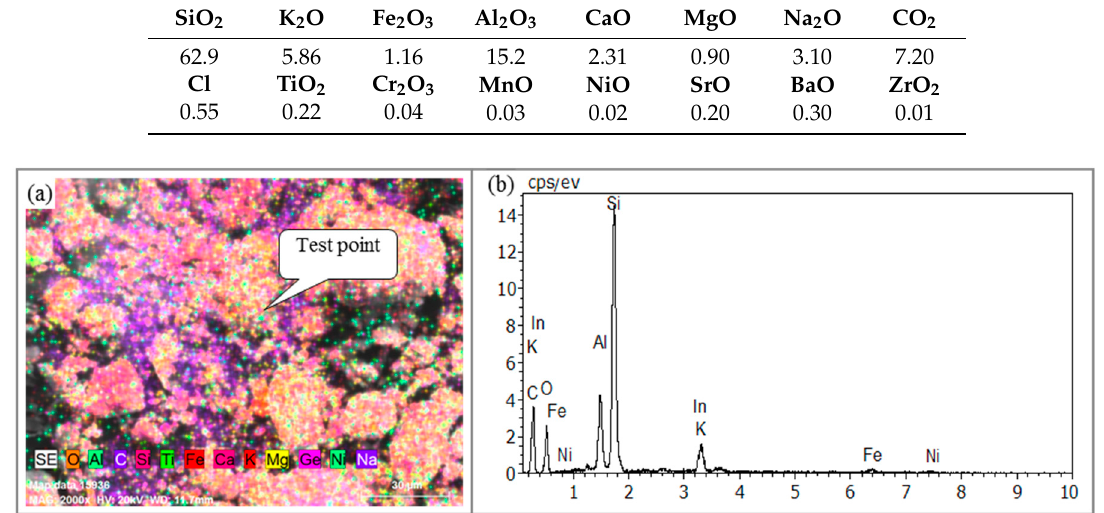
Figure 4. ( a ) General element distribution of the fully tested tailings and ( b ) the element composition of the tested point. Table 1. Main chemical composition of the tailings (wt. %).